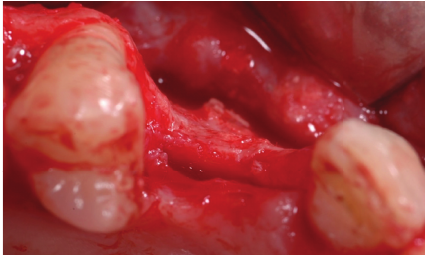
Figure 6: Anatomical view of the occlusal aspect of the edentulous ridge. The horizontal bone resorption is clearly represented.